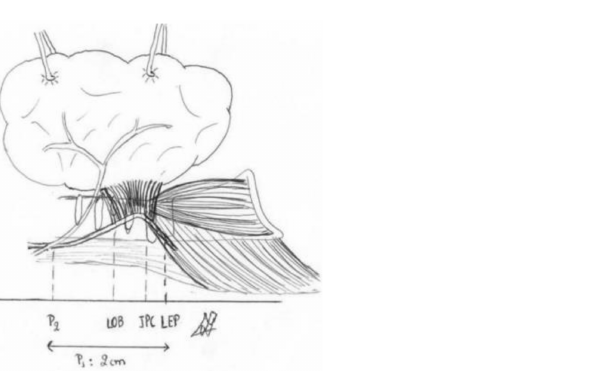
Figure 13. The picture shows P1 and P2 regions (painted by one of the